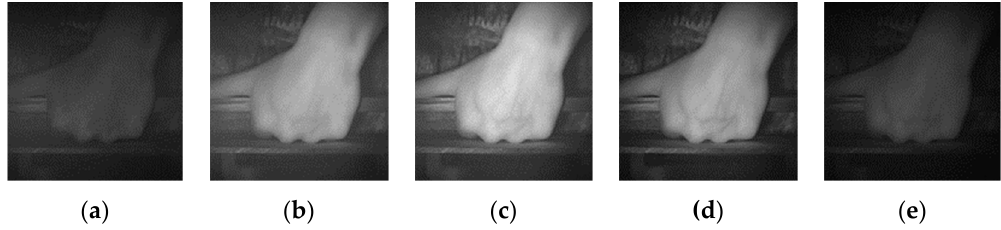
Figure 6. Hyperspectral dorsal hand vein (HDHV) samples from different spectra. ( a ) 560 nm; ( b ) 660 nm; ( c ) 760 nm; ( d ) 860 nm; ( e ) 960 nm.